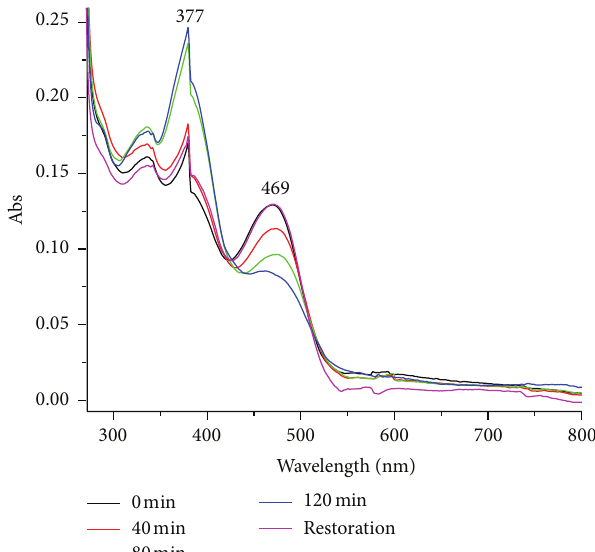
Figure 6: The UV-vis spectra of compound 3 after a period of exposure to UV light.